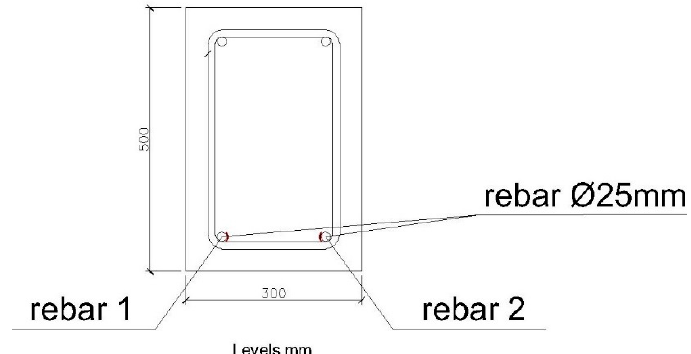
Figure 20. Position of bars studied in 300 × 500 mm beam.